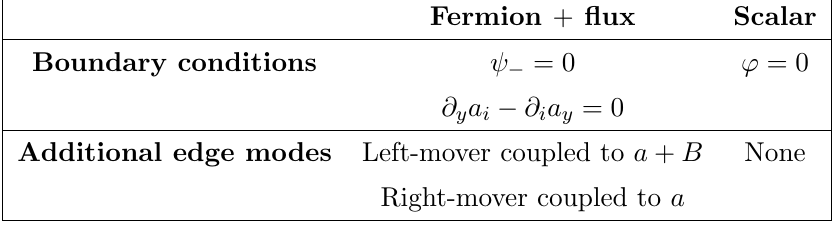
Table 2 . Summary of boundary conditions and additional edge movers for eq.